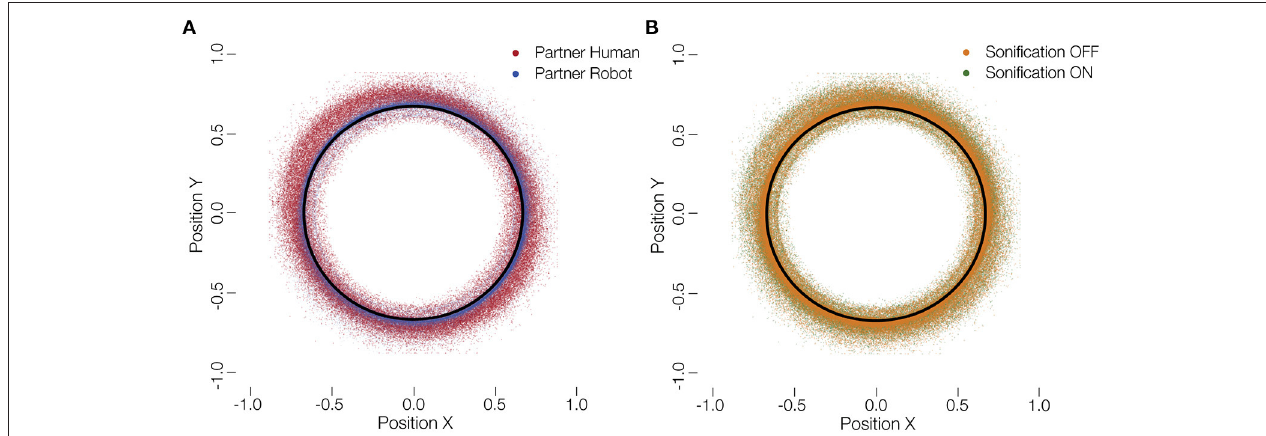
FIGURE 3 | Distribution of ball positions. (A) Ball positions on the tablet with a human (red) and robot (blue) partner. (B) Ball positions on the tablet for sonified (green) and not sonified movements (orange). The black circle represents optimal trajectory. It can be seen that participants deviated more with a human partner. No such difference is visible for a change in the